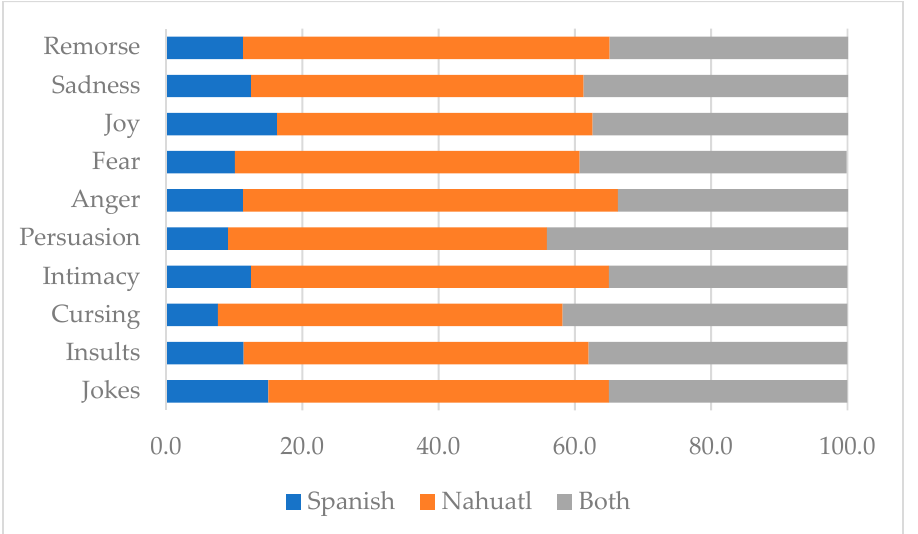
Table 4. Language use in emotional states by age group.